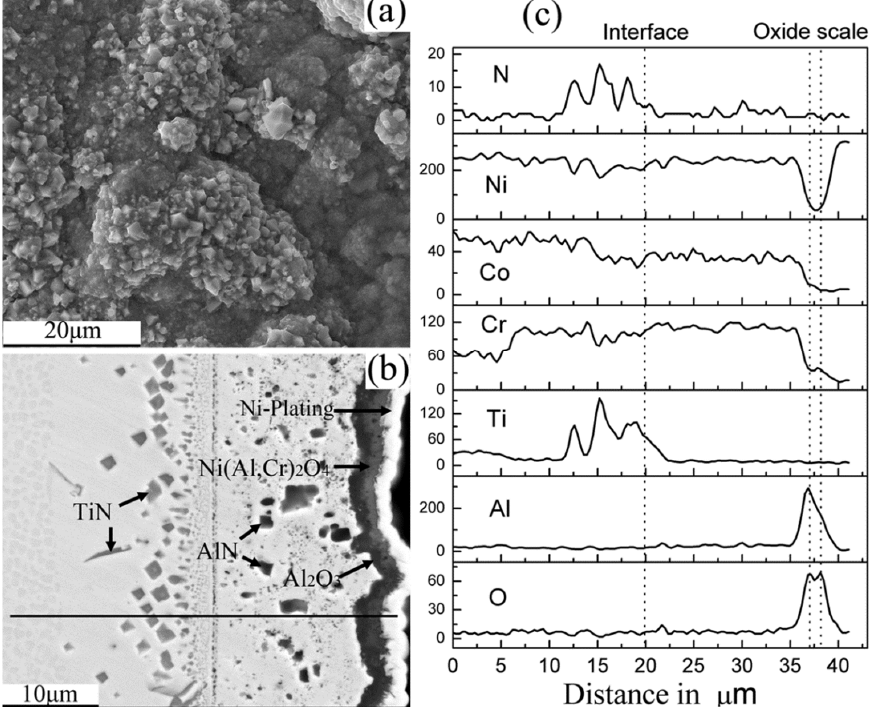
Figure 6. Surface SEM image ( a ), Cross-sectional BSE image ( b ) and the element depth profiles (( c ), analyzed by EDX) of K417/ CrN/Ni+CrAlYSiN coating system after oxidation for 100 h at 1000 °C in air. In contrast, no such interdiffusion zone was observed on K417/AlN/Ni+CrAlYSiN